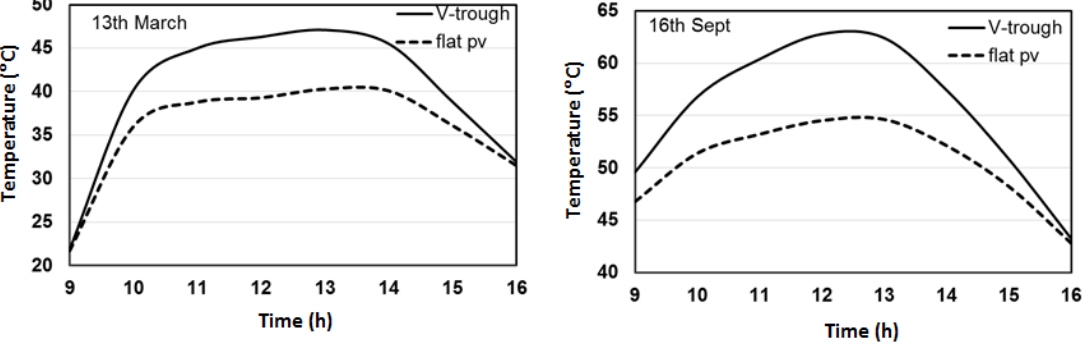
Figure 10. Cell temperature without